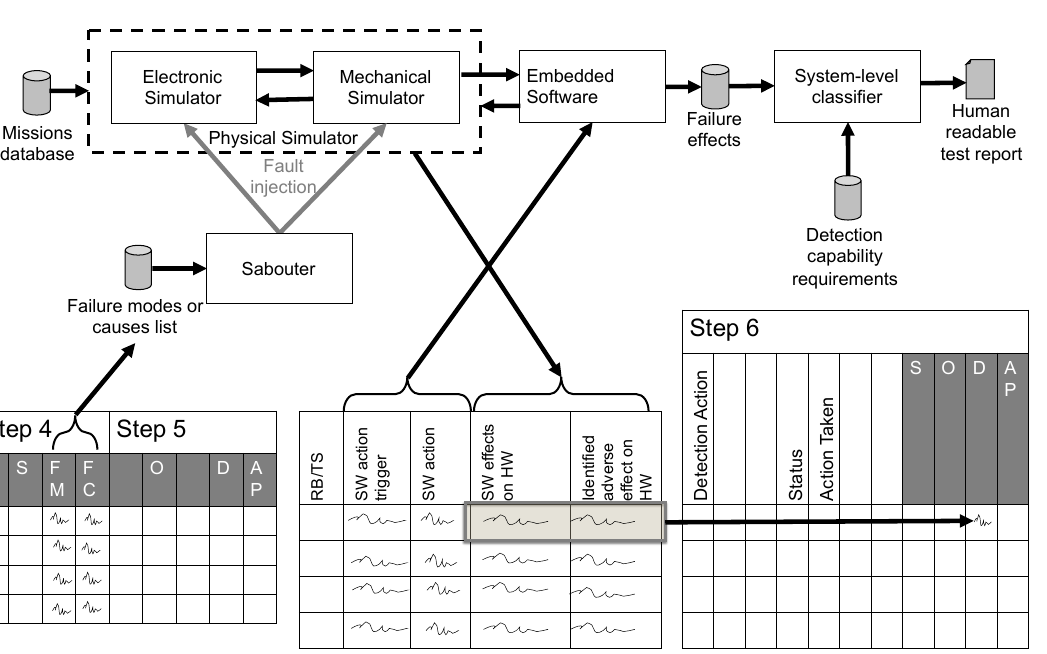
Figure 1. Proposed methodology flow-chart. Tables at both sides follow the structure indicated in [3], while the central one follows the HSIA described in [2]. List of abbreviations from the left to right: severity (S), failure mode (FM), failure cause (FC), detectability (D), occurrency (O), action priority